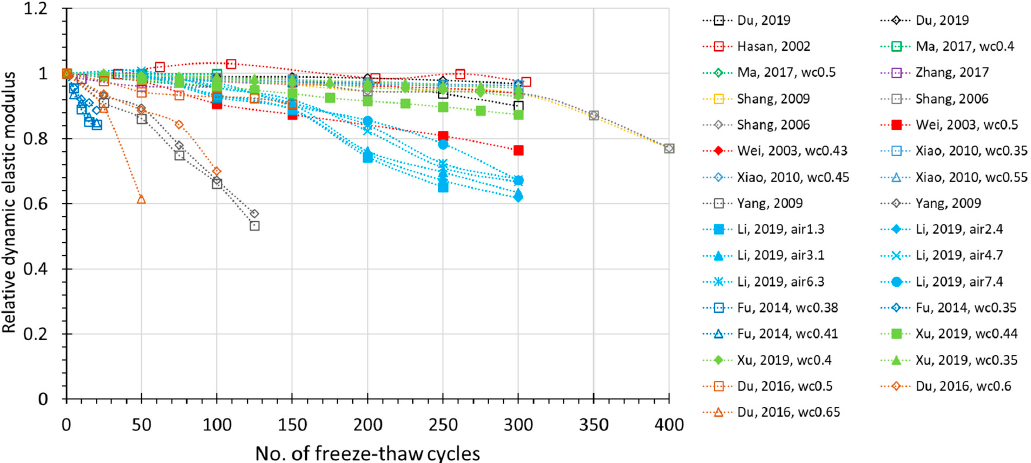
Figure 5. Relative dynamic elastic modulus (RDEM) during FTC for air-entrained concrete (for the same literature, wc —water to cement ratio; air —air content).